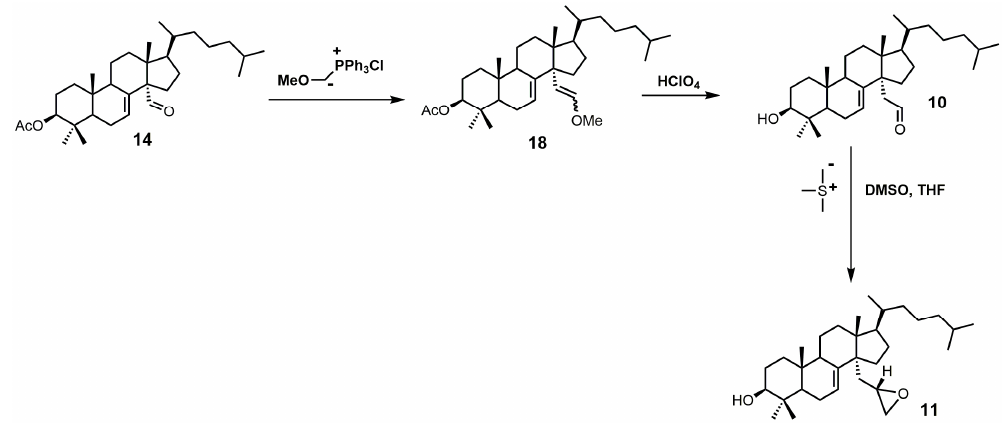
Figure 9. The synthesis of 32 S -oxiranyllanost-7-en-3 β -ol ( 11 ).